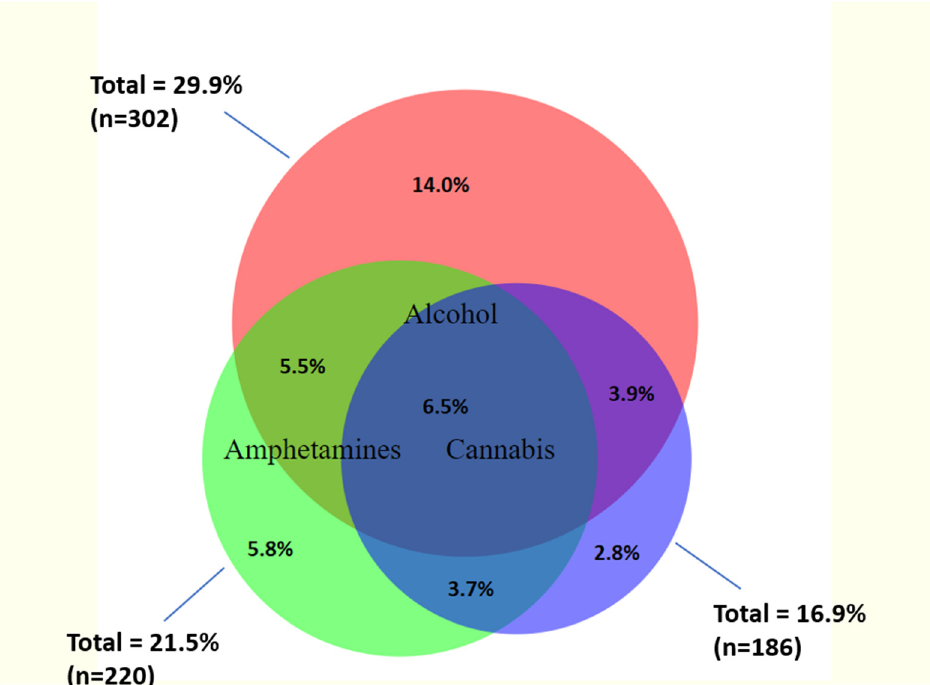
Figure 2. Prevalence and overlap between harmful alcohol, amphetamine and cannabis use among FSWs in Nairobi. Table 2. Multivariable logistic regression—associations with alcohol/substance use and level 1